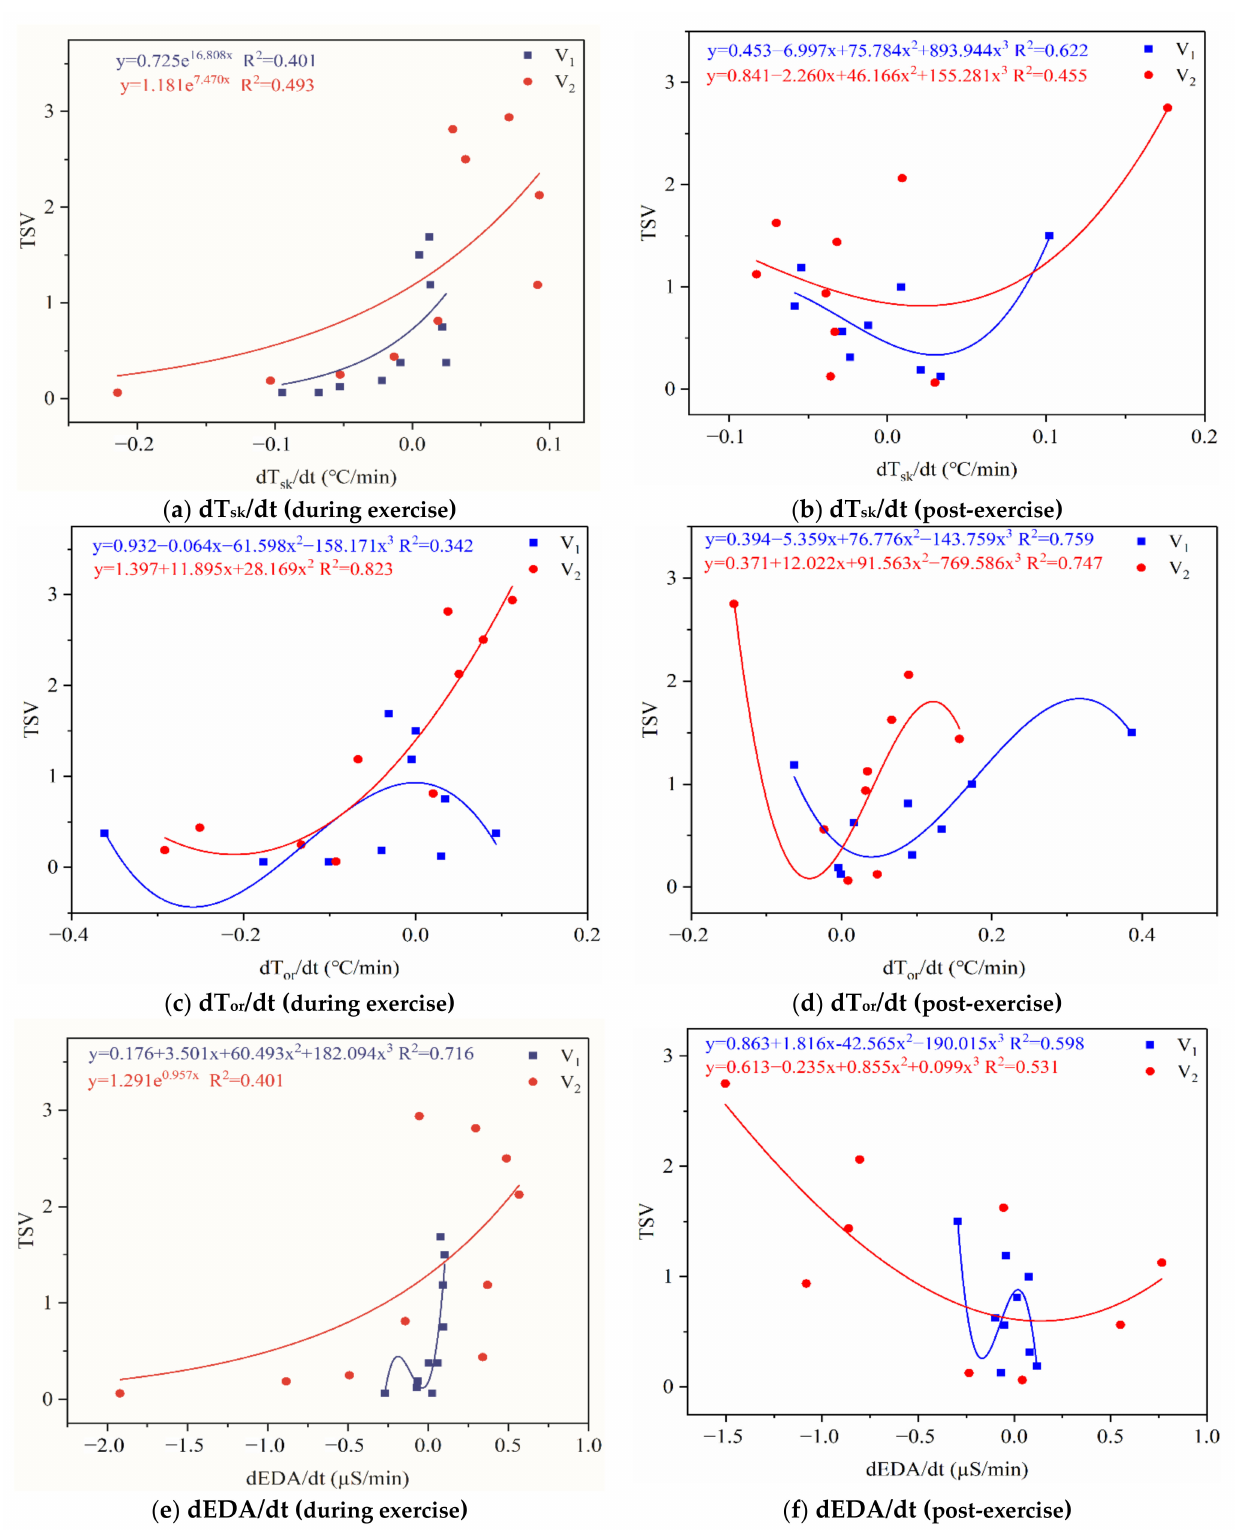
Figure 13. Thermal sensation as a function of the rate of change of physiological